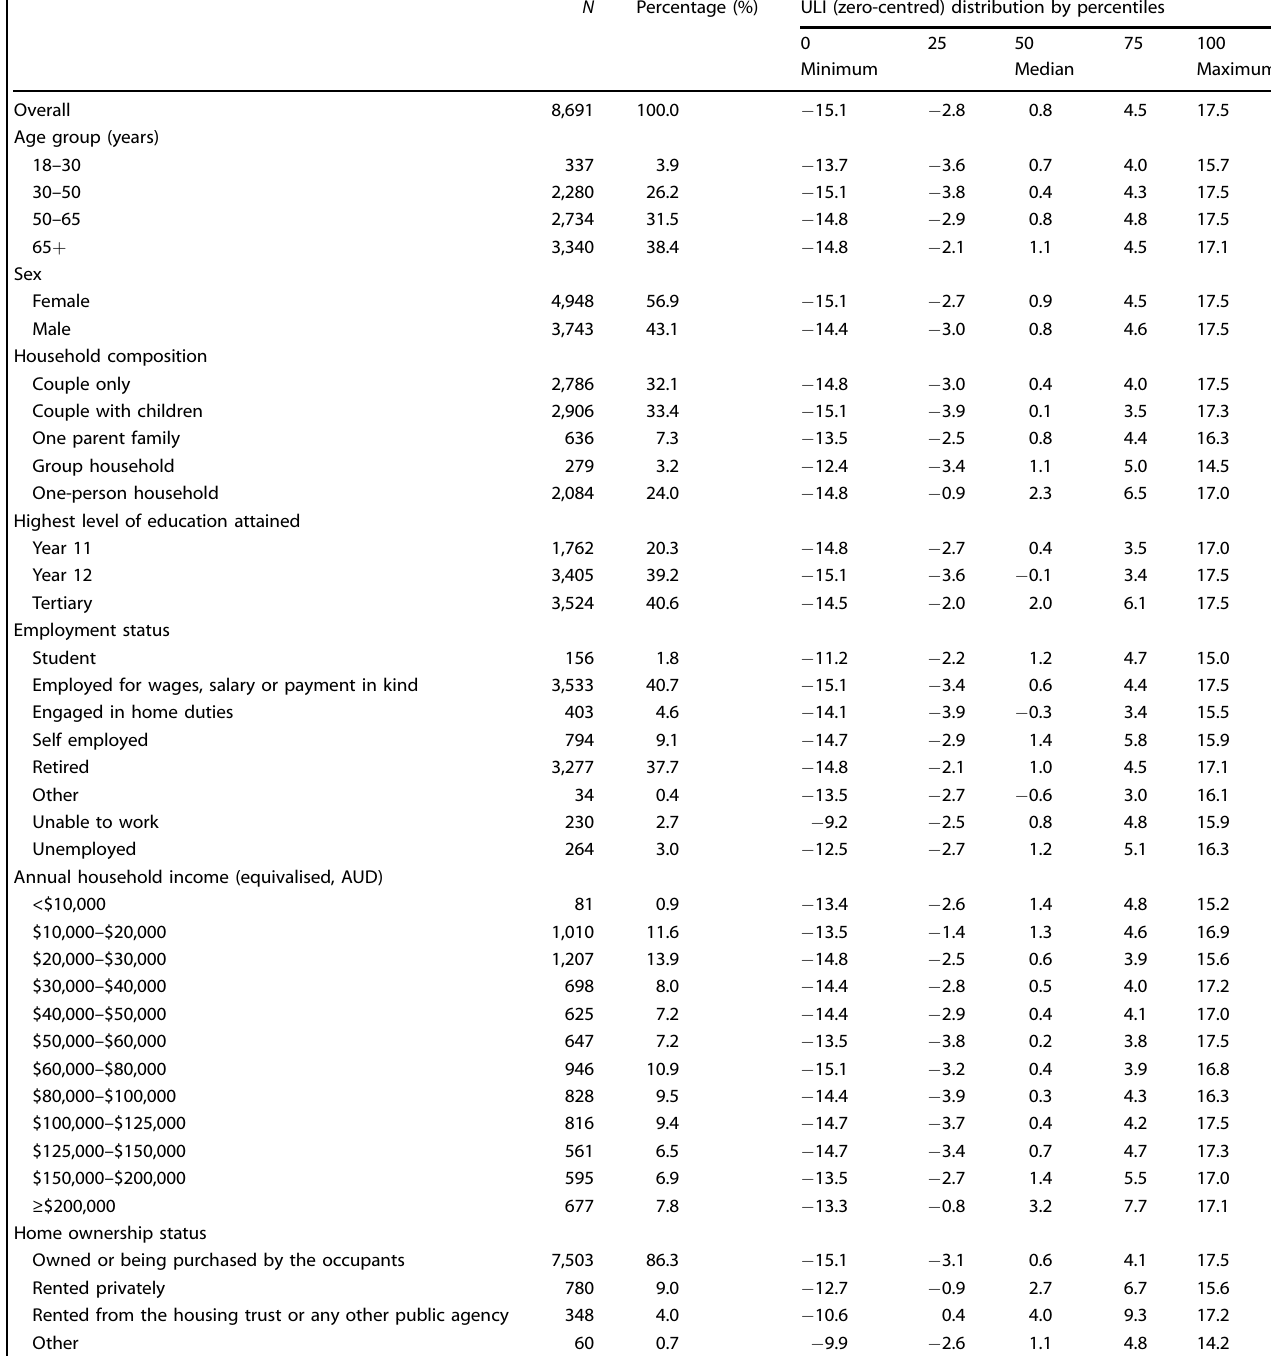
Table 1. Liveability distribution by VPHS participant